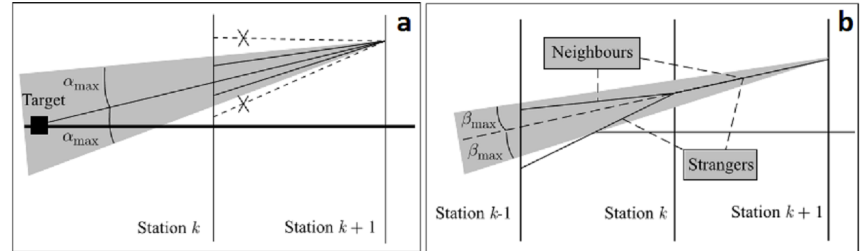
Figure 2. (a) Segment set formation and (b) segments binding procedure